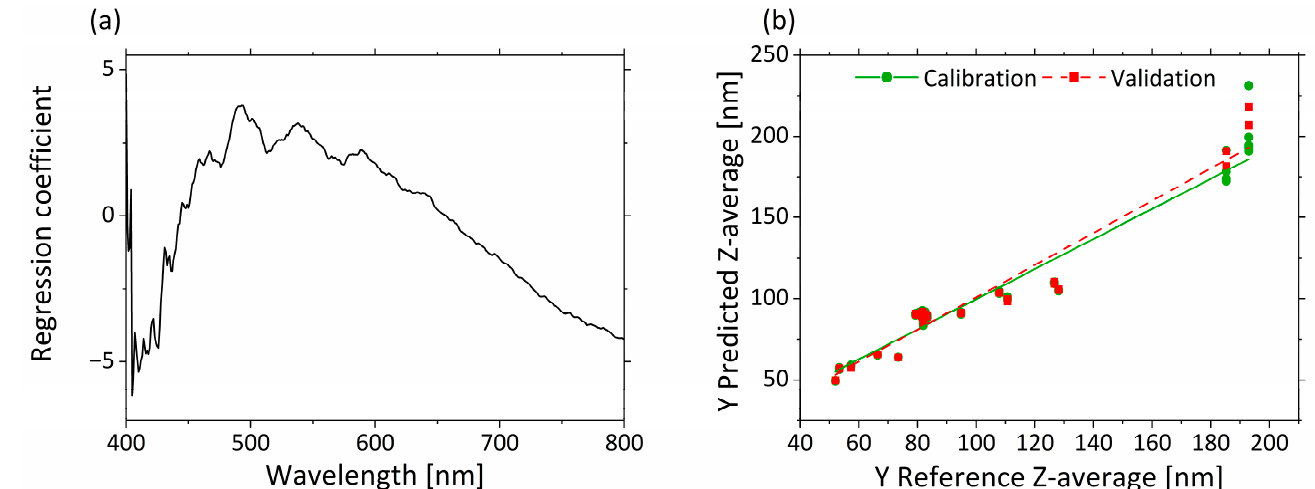
Figure 4. PLS-R with three factors for correlation of µ ’ s and Z-average. The regression coefficients of the three-factor model are shown in ( a ). Predicted vs. reference of Z-average for calibration (green) and validation (red) are displayed in ( b